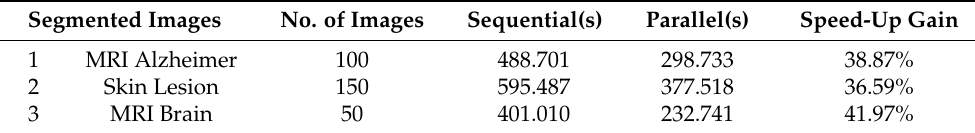
Table 3. Time performance of the proposed algorithm when implemented using parallel processing. Segmented Images